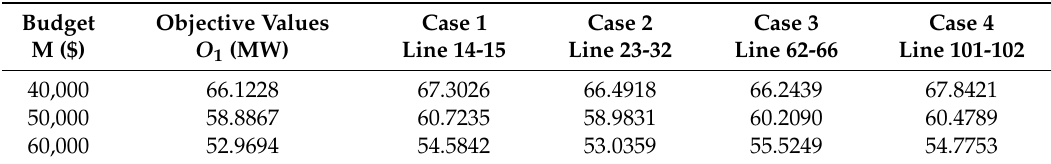
Table 10. Results for one outage on the IEEE 118-bus system.